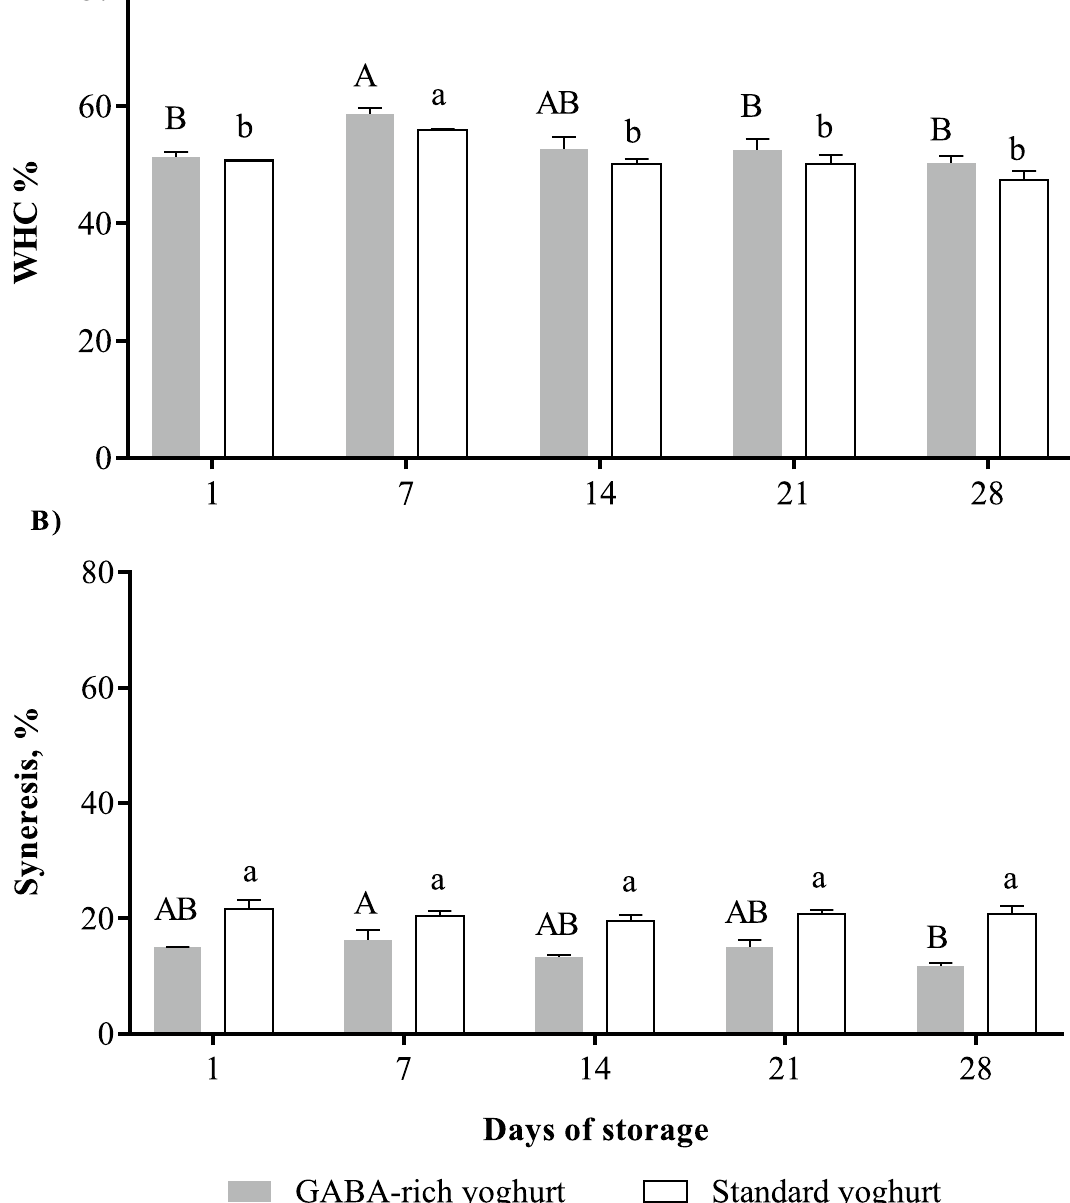
Figure 4. Effect of refrigerated storage on ( A ) WHC and ( B ) syneresis of GABA-rich yoghurt compared to standard yoghurt. Different letters indicate significant difference ( p < 0.05) for GABA-rich yoghurt (capital letters) and standard yoghurt (small letters) on different days of